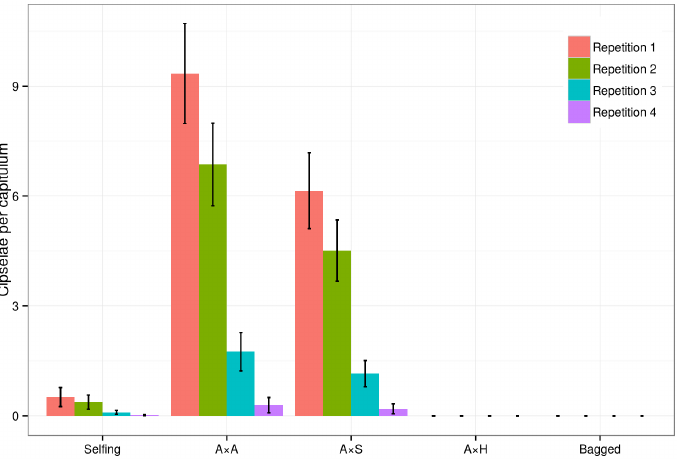
Fig 2. Predicted values for the diploid Centaurea aspera by the Poisson model. Colors represent the repetitions; red: first repetition; green: second; blue: third and purple: fourth. Selfing: self-pollination; A×A: cross-pollination between individuals of C . aspera (intraploidy); A×S: coss-pollination between mother diploid C . aspera and father tetraploid C . seridis ; A×H: cross-pollination between mother diploid C . aspera and father triploid C . × subdecurrens ; bagged: bagged treatment without brushing. Error bars indicate the standard error for the Poisson model estimates.